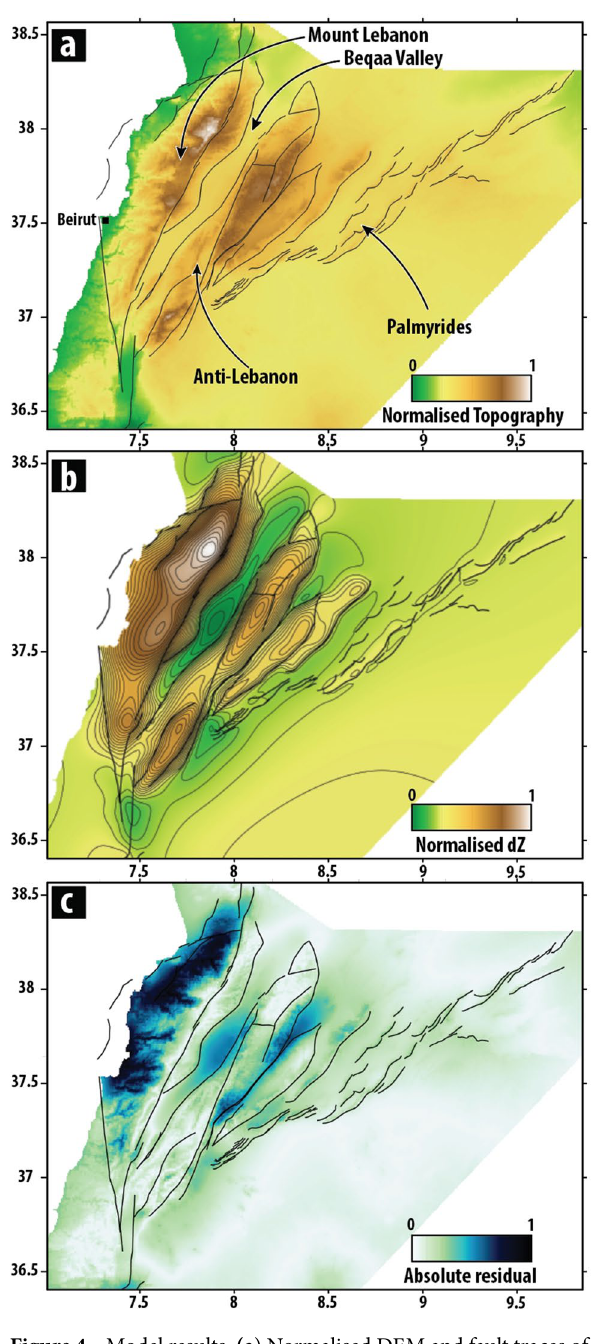
Figure 4. Model results. (a ) Normalised DEM and fault traces of LRB used in the numerical model. Main structural features are listed. ( b ) Normalised vertical displacement (dZ) produced by our model with a σ1 value of N140. Results of our model with σ 1 ranging from N120-N180 are shown in Supplementary Information. ( c ) Absolute residual highlighting the main discrepancies between the normalised topography and normalised